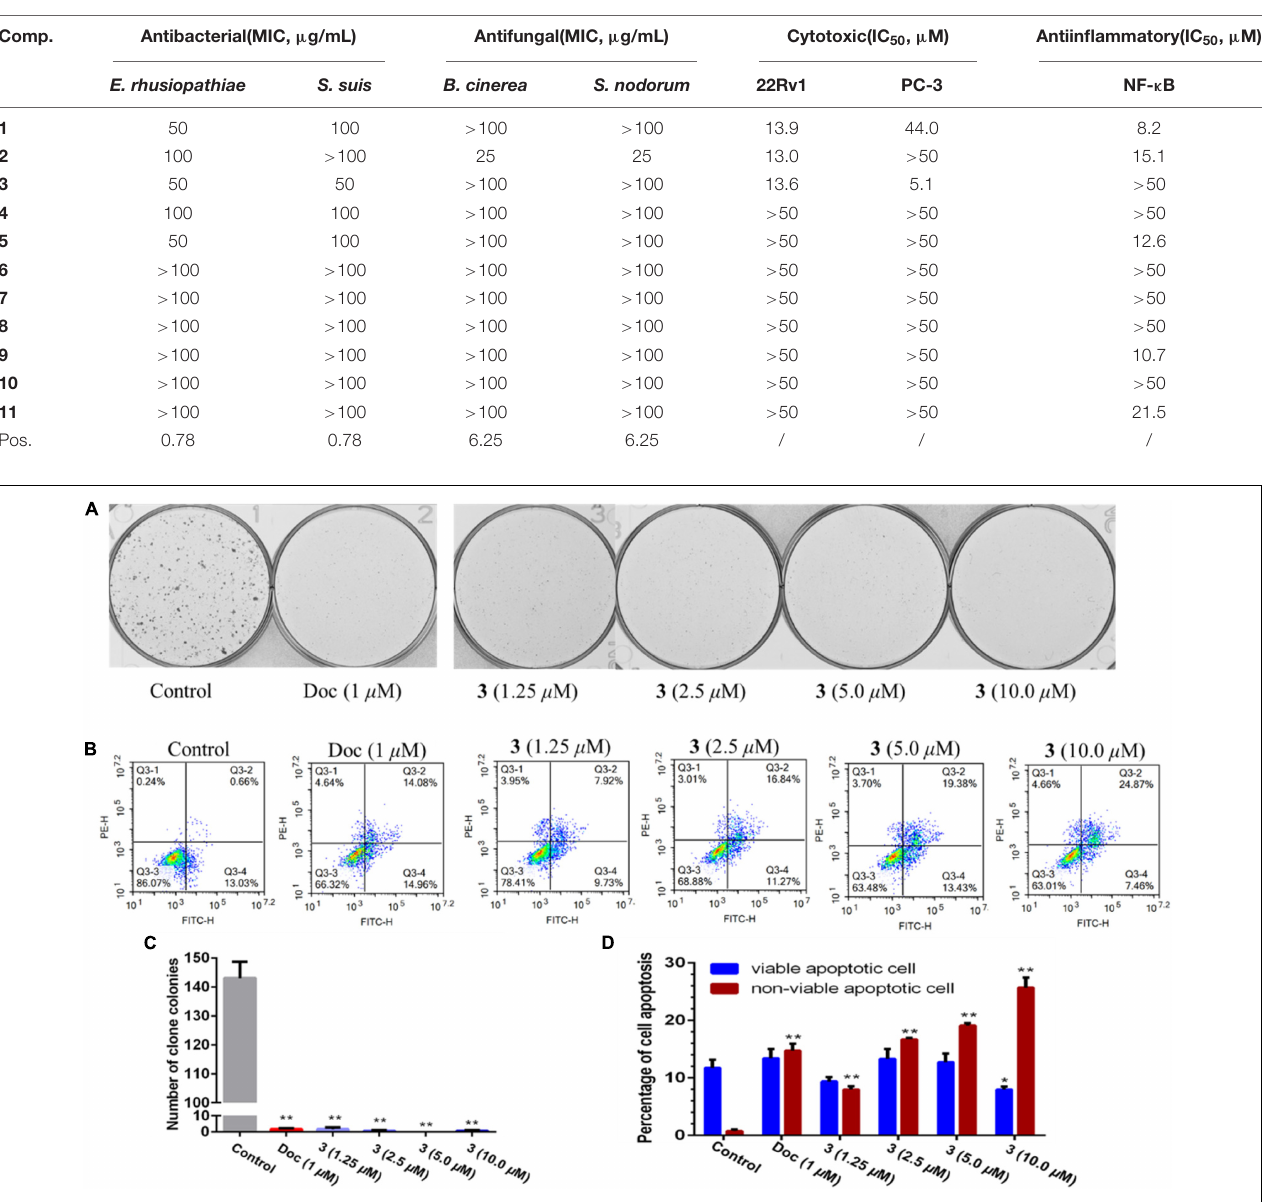
FIGURE 4 | Compound 3 reduced PC-3 cells colony formation (A,C) and induced apoptosis (B,D) . All results were presented as mean ± SD. Statistical significance was determined with one-way ANOVA. * P < 0.05 and ** P < 0.01 were considered statistically